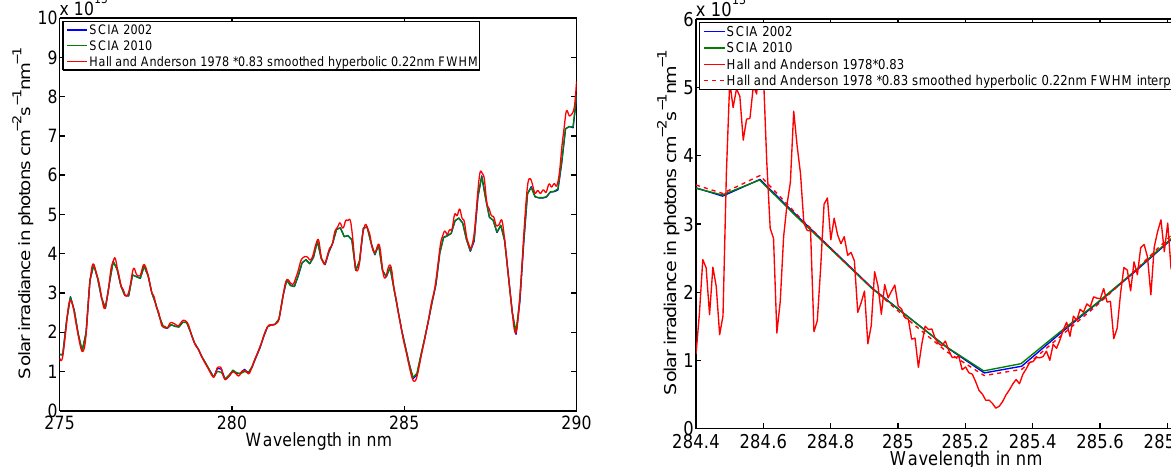
Fig. 11. SCIAMACHY solar spectrum in the Mg 285.2nm line re- gion for low (2010) and high (2002) solar activity in comparison with the scaled high resolution reference spectrum. When the high resolution spectrum is smoothed and sampled as the SCIAMACHY spectrum, there are only small differences left, mainly resulting from different phases of the solar cycle for the different spectra. Note that a scaling factor of 0.9 instead of 0.83 is used for Mg in the retrieval because this fits better for the line center.